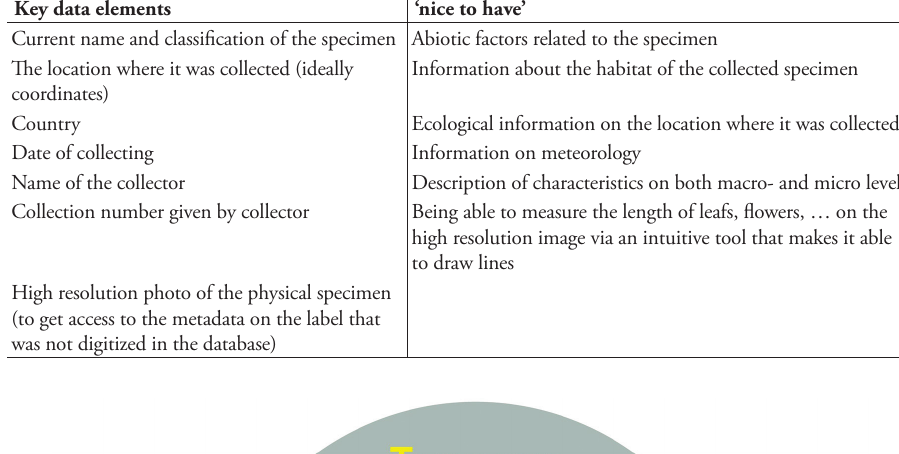
Table 2. Common data elements identified across the different researcher categories as being important to their